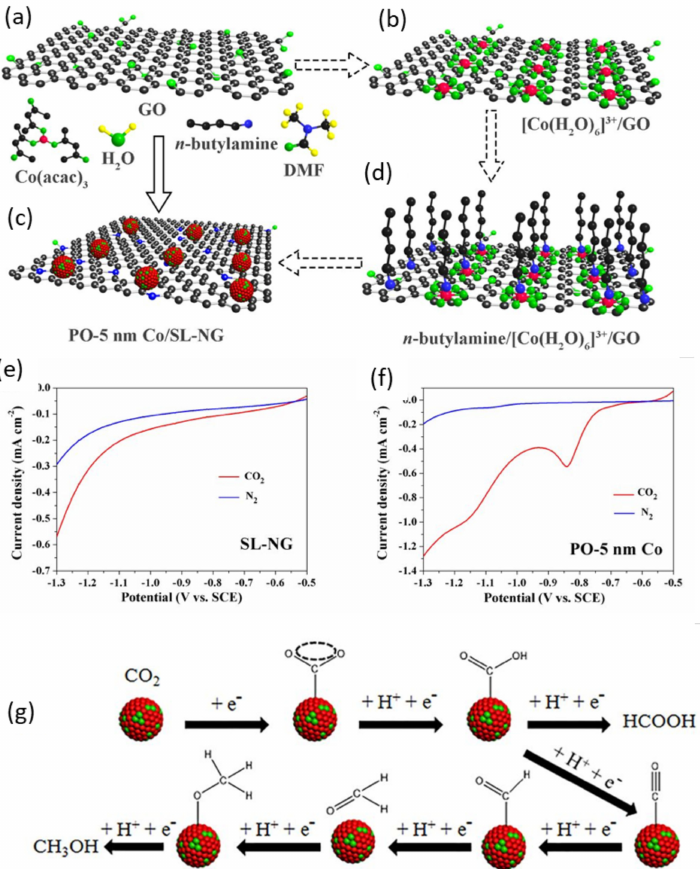
Figure 3. Scheme for the single-step synthesis of PO-5 nm Co/SL-NG ( a – d ). Linear-sweep voltam- mograms of SL-NG catalyst, ( e ) PO-5 nm Co catalyst and ( f ) 30.87 wt% PO-5 nm Co/SL-NG catalyst in saturated CO 2 (red-line) and saturated-N 2 (blue-line) 0.1 mol dm − 3 NaHCO 3 electrolyte and the mechanism of CH 3 OH production ( g ). Reproduced from [120], with permission from American Chemical Society,